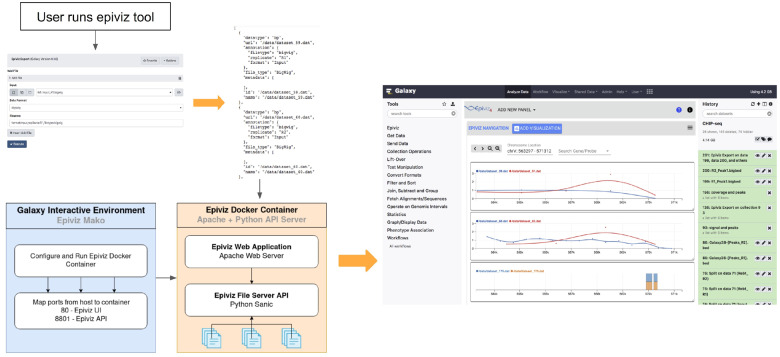
Overview of Epiviz integration with Galaxy. Users can include the Epiviz Galaxy Tool in a workflow to choose files and define annotations to generate an Epiviz configuration file. A Galaxy IE using the Epiviz configuration spins the Epiviz docker instance. Once the docker image loads, Galaxy embeds the user interface from the instance on its user interface as shown on the right